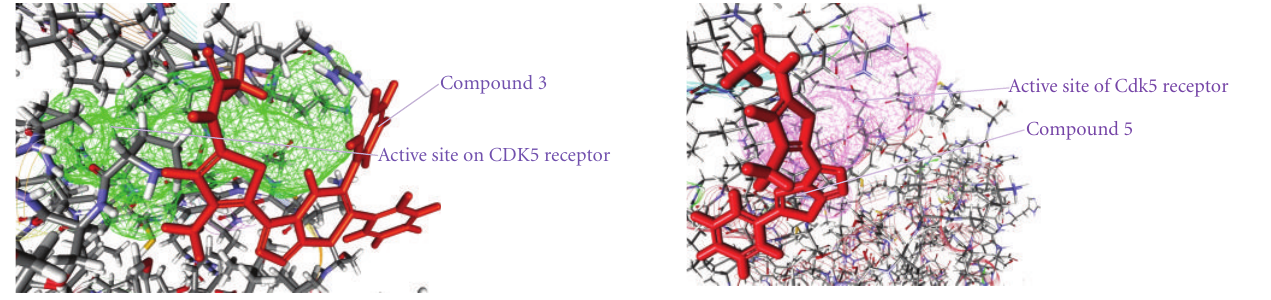
Figure 4: The docked conformation of compound 3 with the receptor CDK5/p25 (PDB: 3O0G). Compound 3 is indicated by red color while the most active site of the CDK5 receptor is shown with green color.